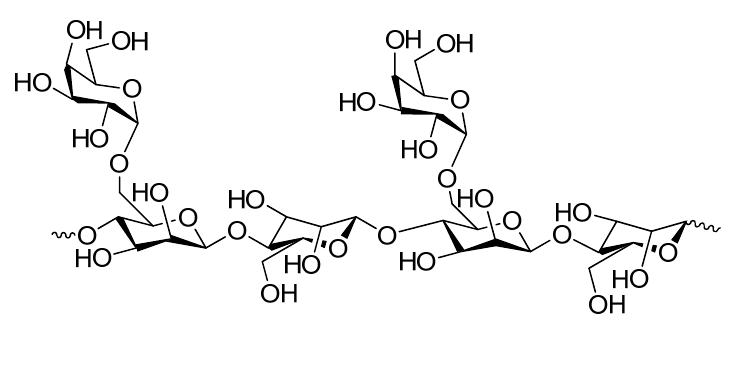
Figure 7. Chemical structure of guar